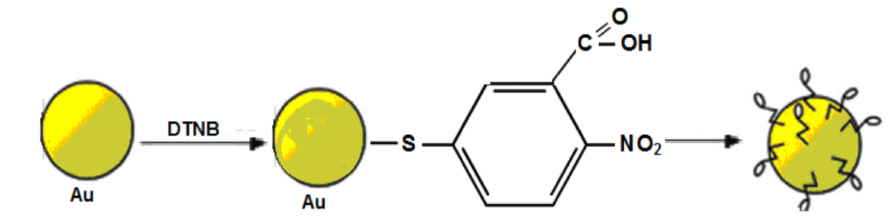
Figure 16. Principle scheme for preparation of AuNP-DTNB conjugate.